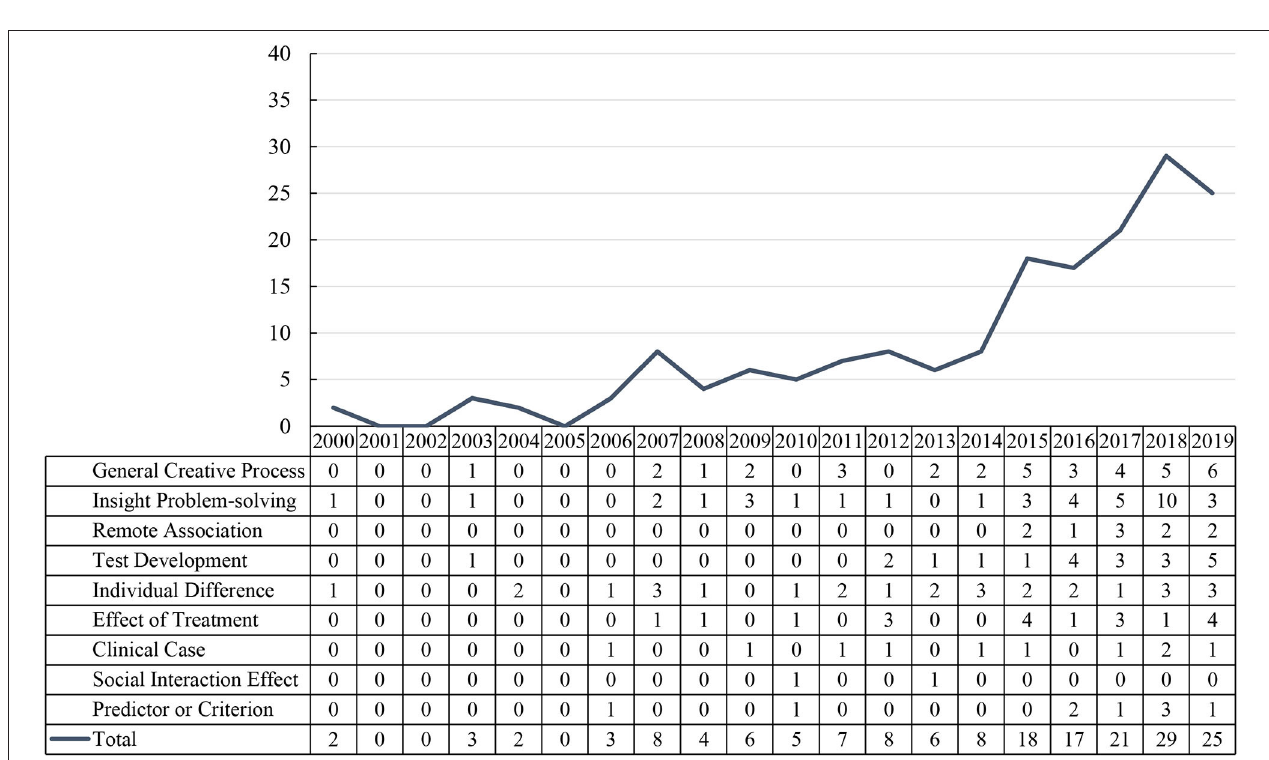
FIGURE 2 | Number of studies in each creativity-related research category from 2000 to 2019.